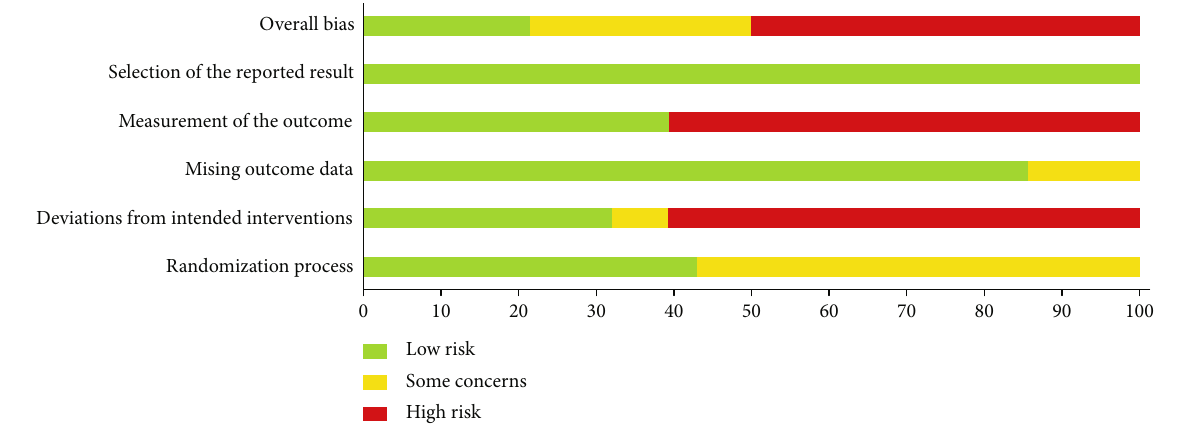
Figure 3: Risk of bias summary.